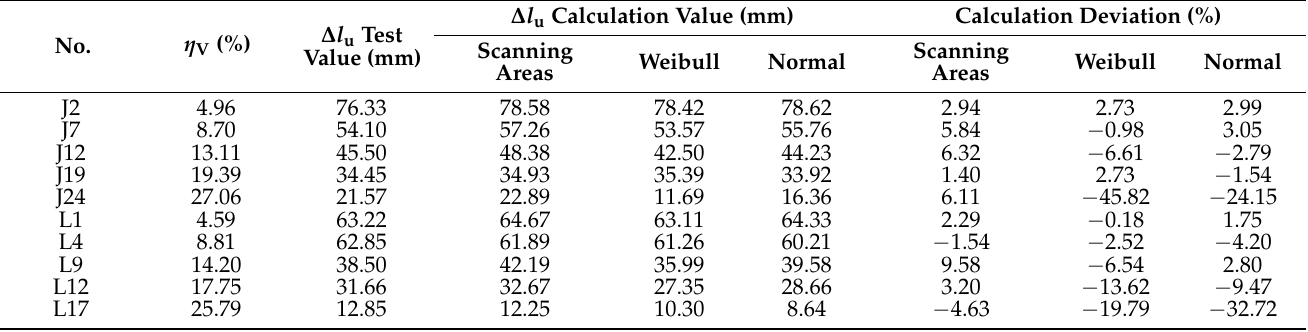
Table 6. Tensile deformation at the maximum load based on various cross-sectional area